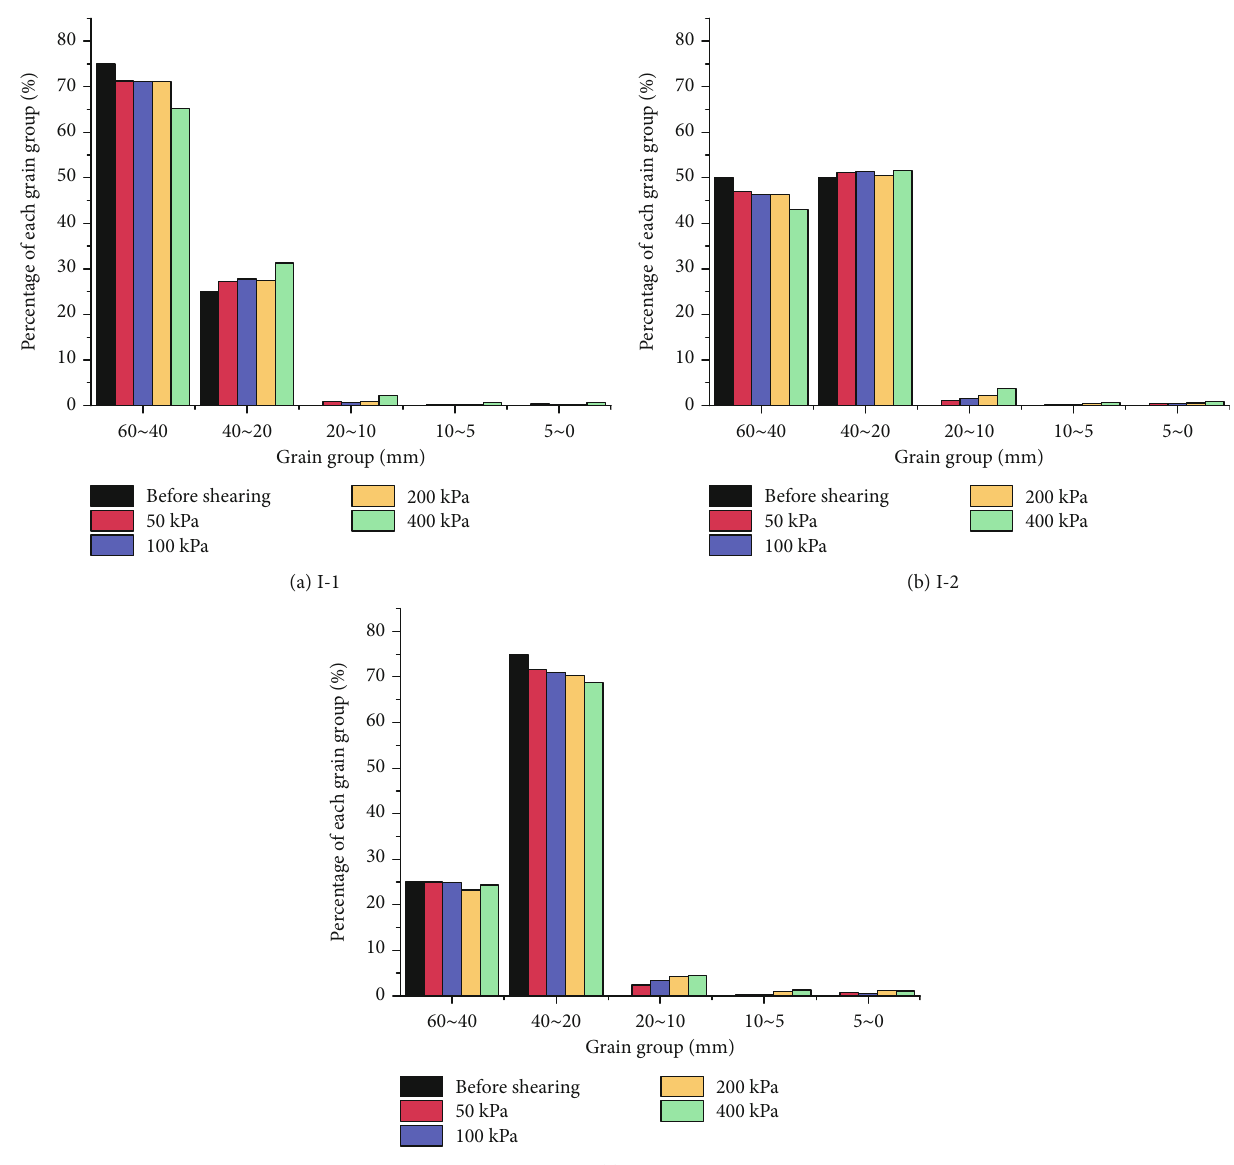
Figure 10: Histogram of contents of each grain group before and after shearing of group